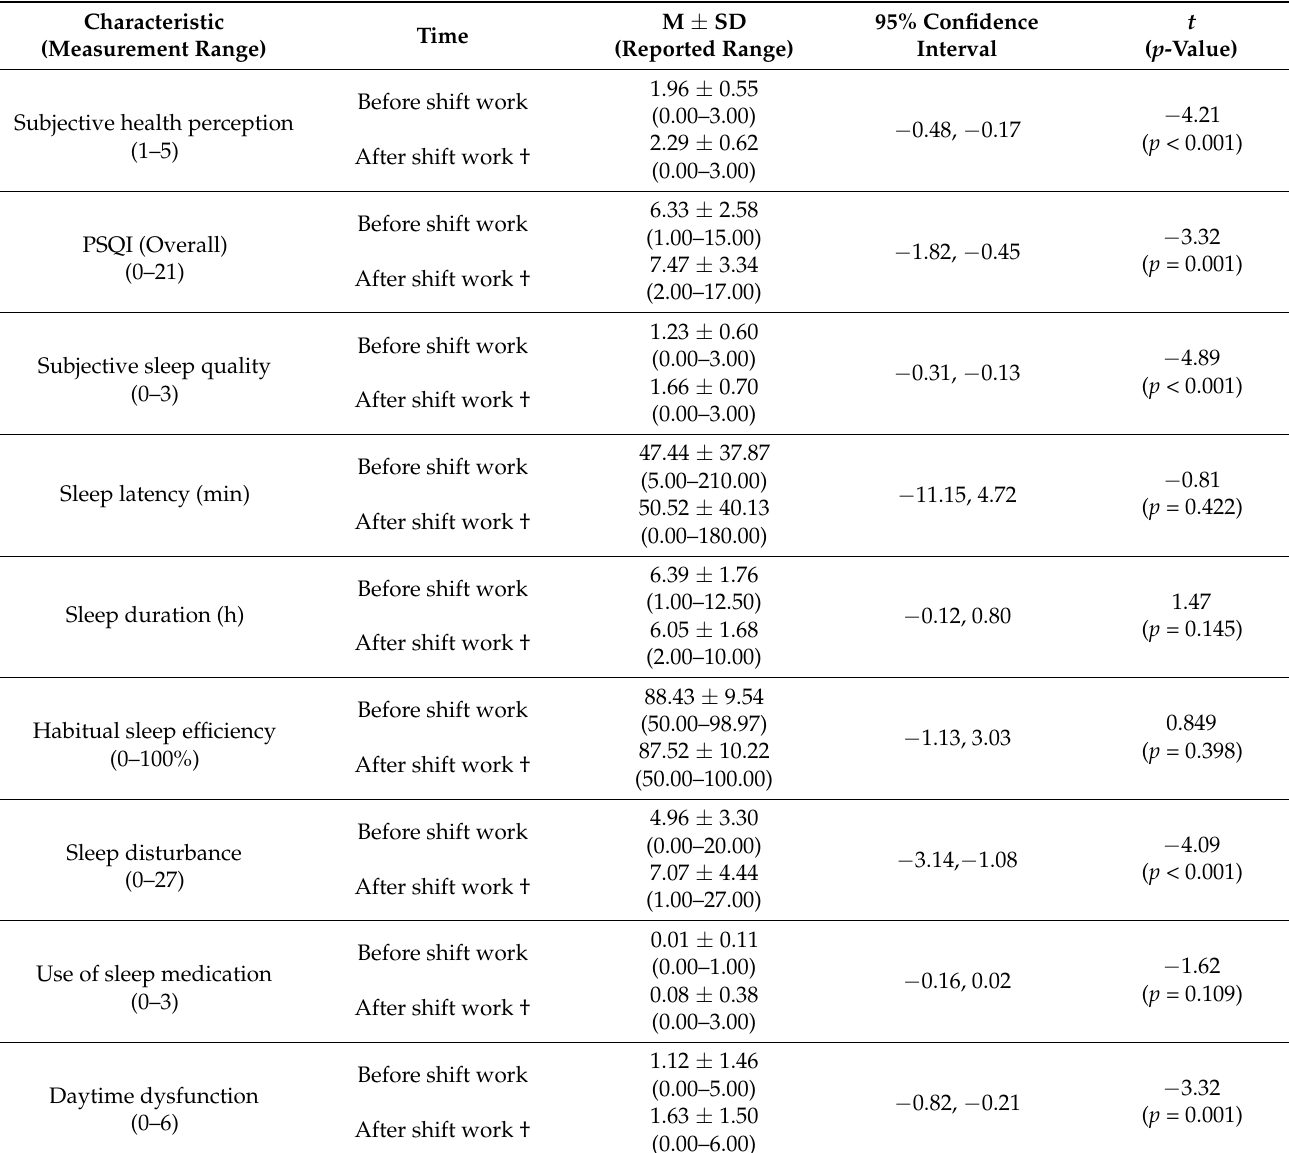
Table 2. Subjective health perception, sleep characteristics, and quality of sleep according to measure- ment time (graduate-transition) ( N =